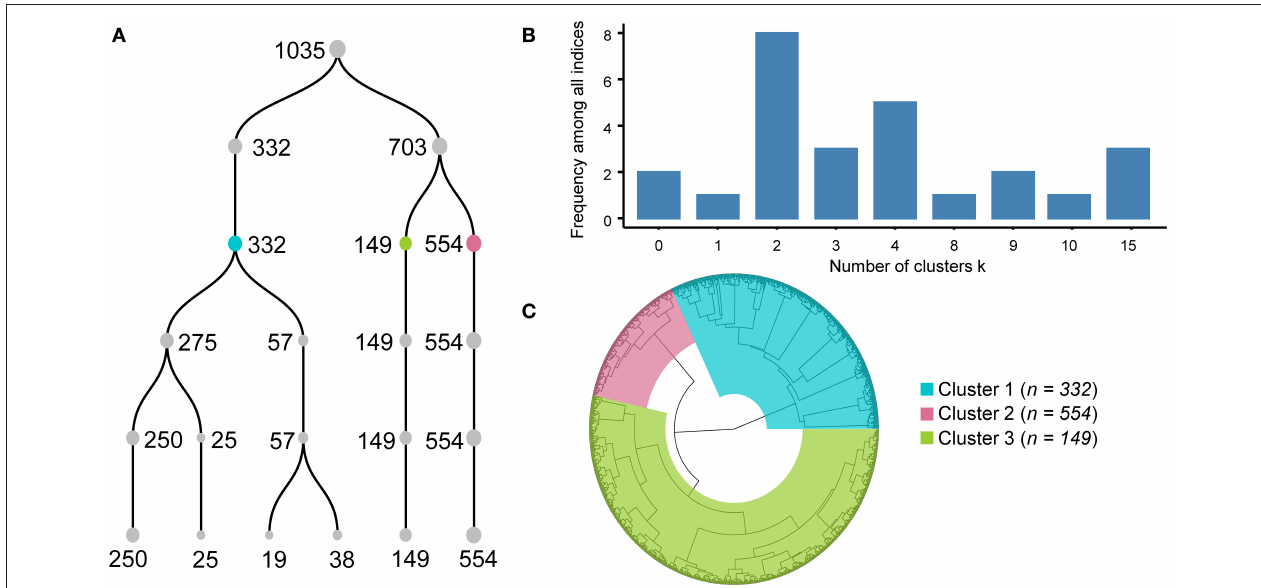
FIGURE 2 | Processes and results of factor analysis of mixed data-based cluster analysis. Dendrogram (A) shows the processes of combination from six clusters to one cluster. Each number near the point means the number of individuals in each cluster. Histogram (B) illustrated that different algorithm in R package NbClust supported different clustering scheme, and dividing into two, three or four clusters were endorsed by the majority of algorithms. Circular dendrogram (C) shows the total processes of cluster analysis. Cluster results are colored blue for Cluster A, green for Cluster B, and red for Cluster